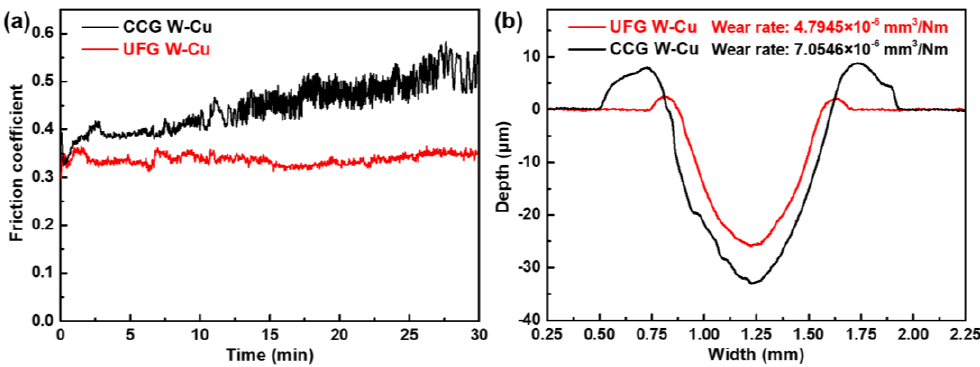
Figure 3. Friction coefficient curves ( a ) and wear scar profiles ( b ) of the CCG W–Cu and UFG W–Cu composites, respectively.